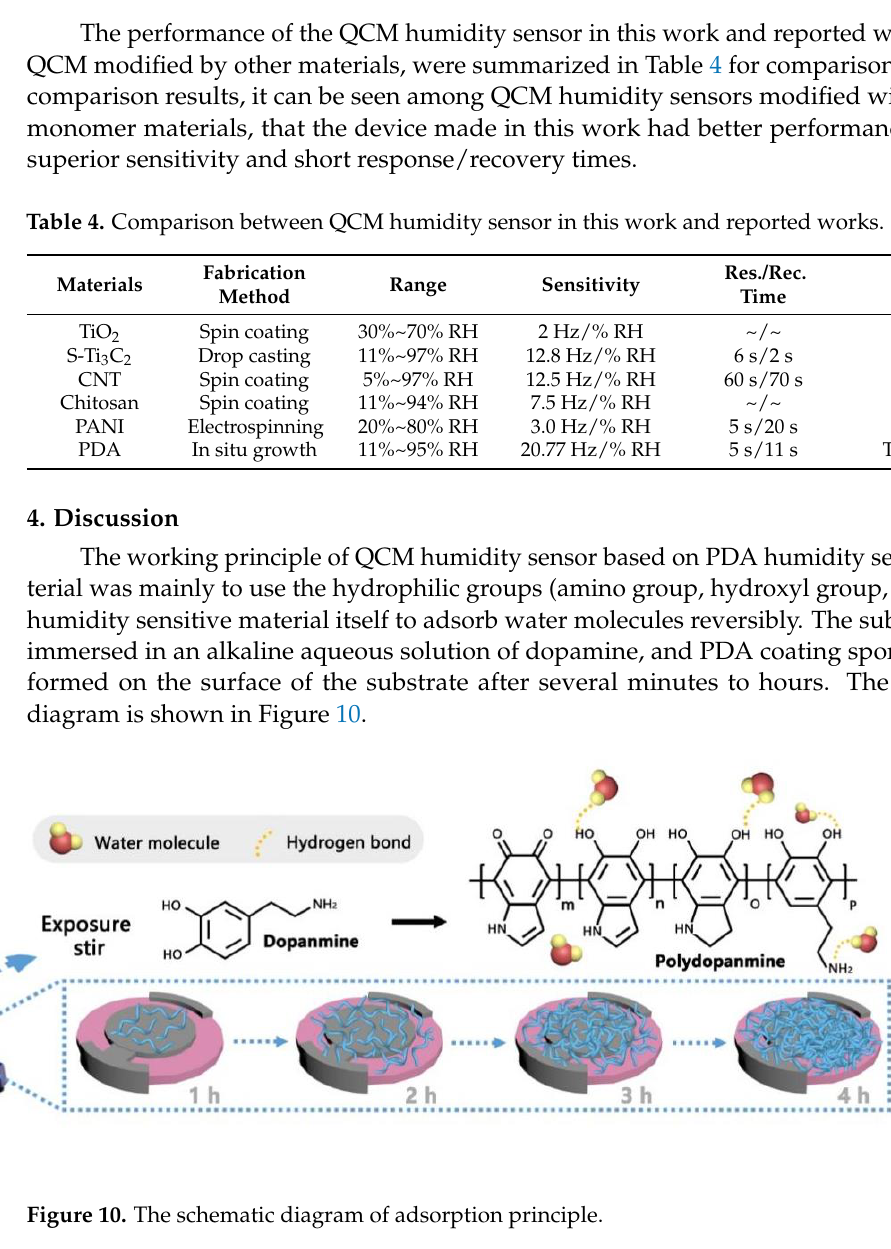
Table 4. Comparison between QCM humidity sensor in this work and reported works.